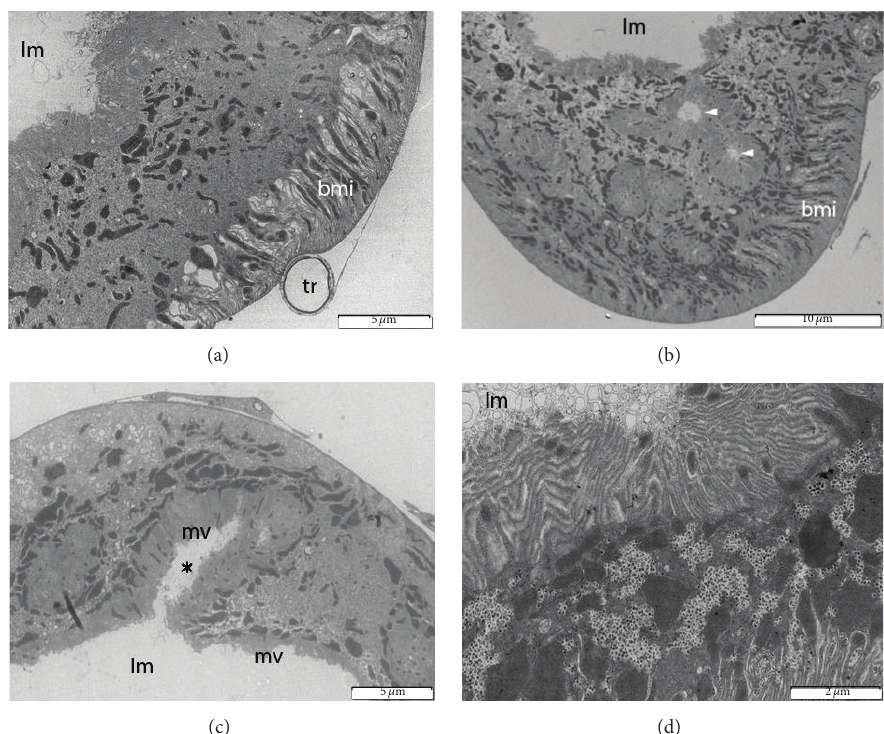
Figure 5: Excretory cells of the Malpighian tubules of Mapuchea chilensis. ((a)–(c)) Adult insects, general structure of the cells. (d) 3rd instar nymph, an excretory cell showing deposits of granular glycogen and lamellar microvilli bordering an intracellular canaliculus. lm: tubule lumen; tr: trachea; and bmi: basal membrane infoldings. Intracellular canaliculi are shown with arrowheads in (b) and an asterisk in